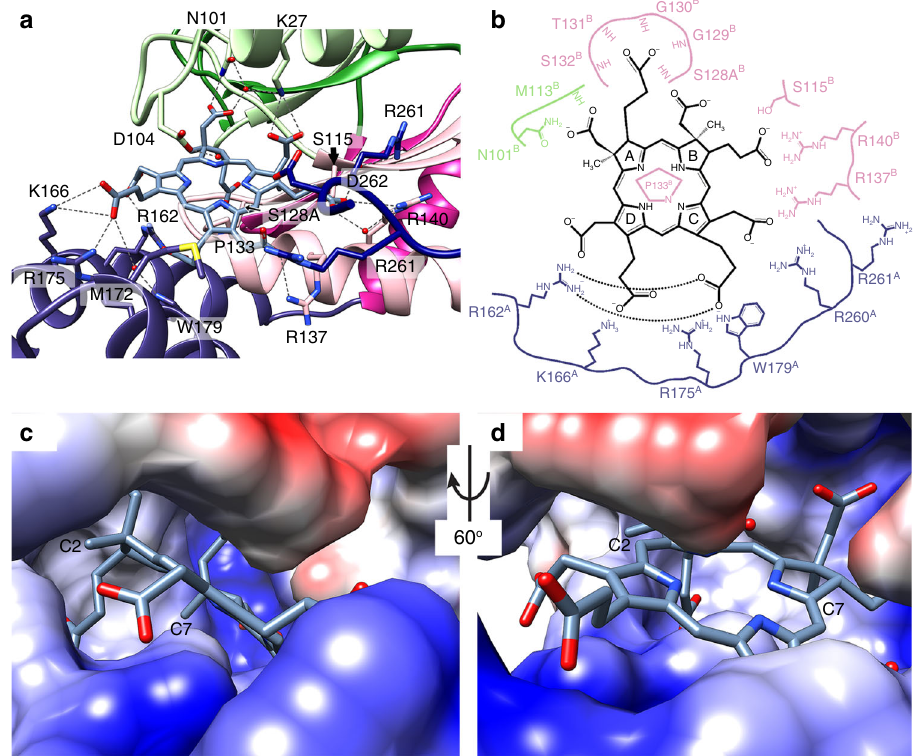
Fig. 3 Charged pockets bind the tetrapyrrole. a Extensive contacts coordinate sirohydrochlorin. b Charge – charge side chain and hydrogen bond main chain interactions coordinate each corner of the tetrapyrrole. c , d The active site is predominantly positively charged (blue) to counter the highly negatively charged sirohydrochlorin, except for the negative charges from D104 and D262 (red) and hydrophobic pockets that position C2 and C7. The electrostatic surface was calculated with UCSF Chimera ’ s Electrostatic Surface Color 38